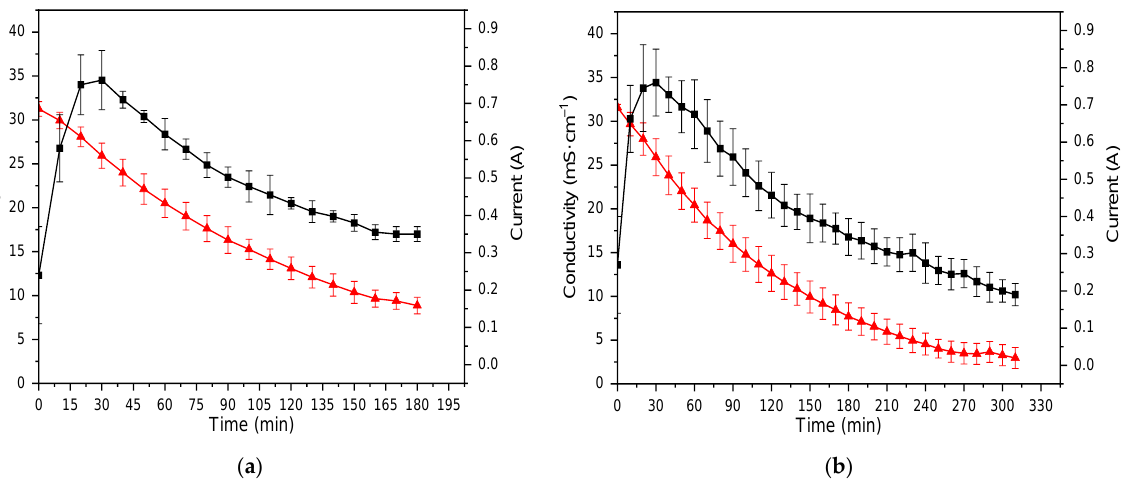
Figure 2. Changes in the conductivity ( ▲ ) and current ( ■ ) for ( a ) LML R70; ( b ) during ED desalination of LML R90.